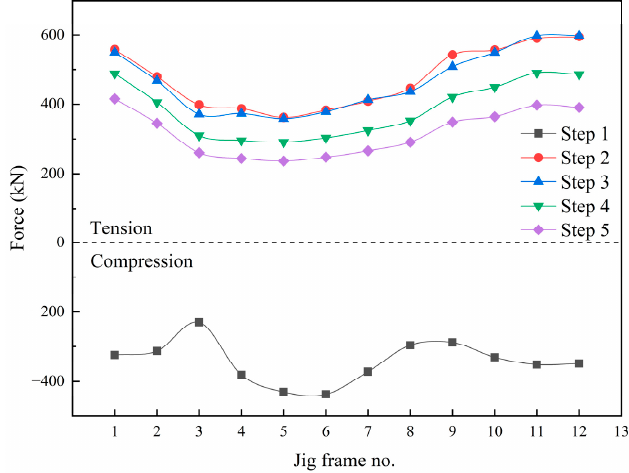
Figure 12. Force variation in the jig frames during the construction process.